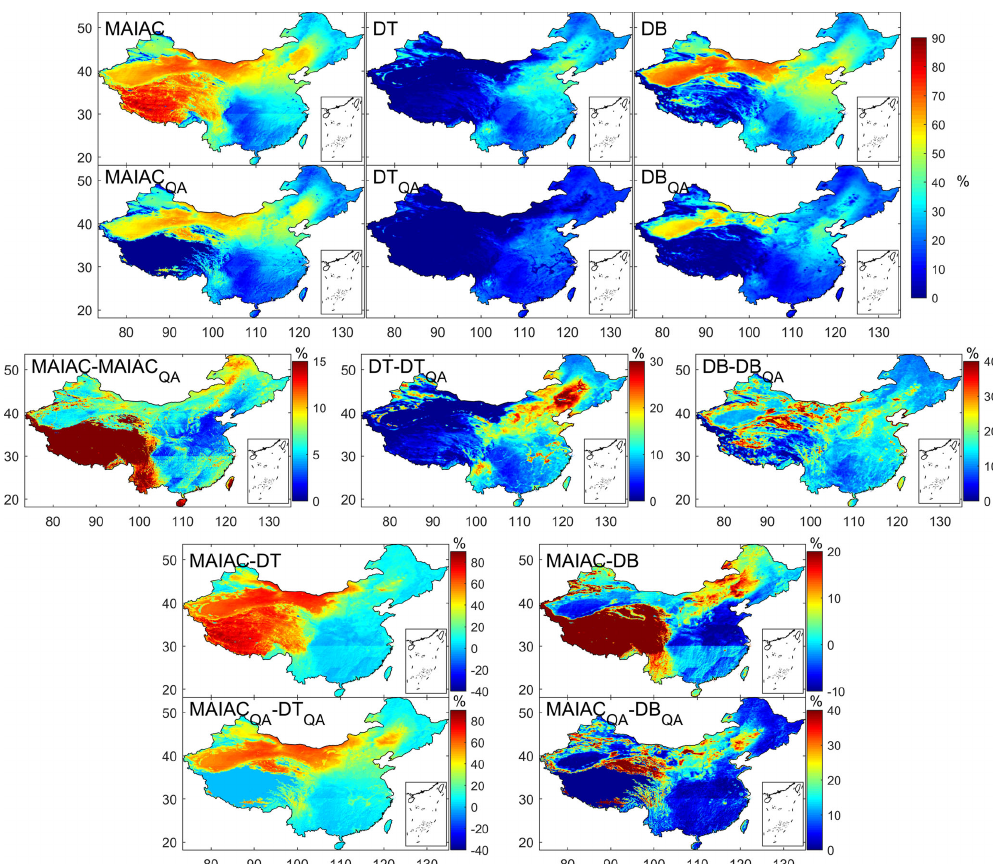
Figure 16. Spatial distributions of temporal completeness for MAIAC, DT, and DB before and after the QA filter and their differences from 2000 to 2017. The subscript QA denotes the corresponding results after the QA